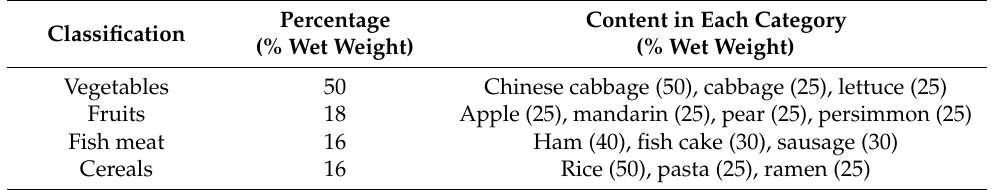
Table 1. Composition of food waste used in this